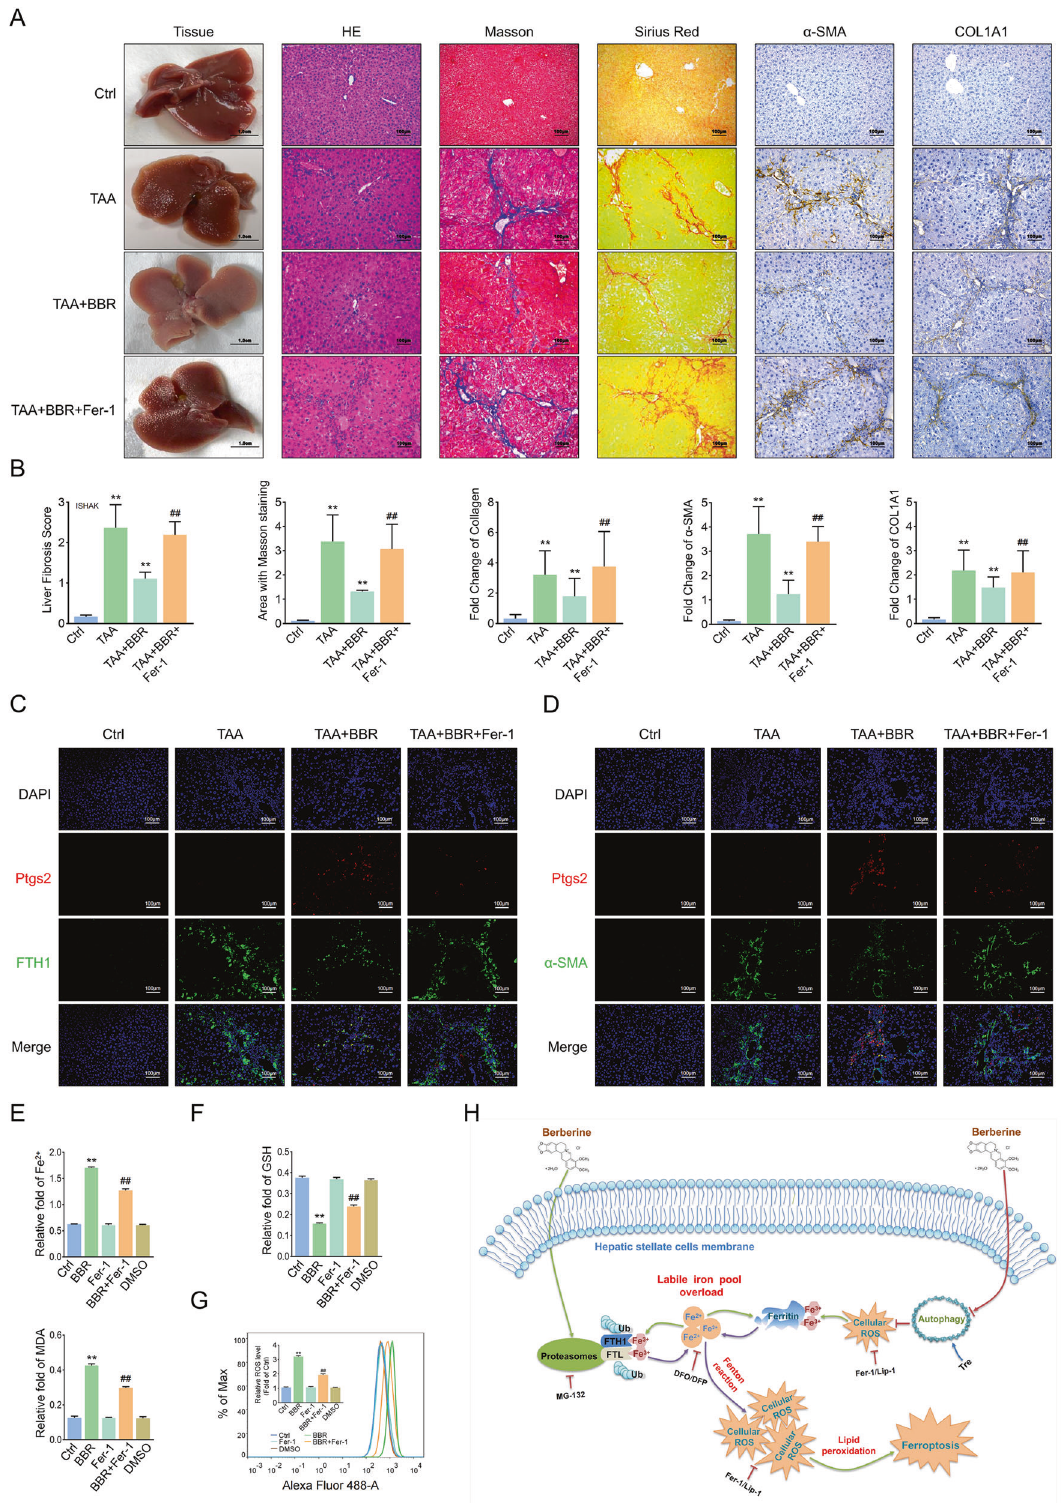
Fig. 8 Blockage of ferroptosis offsets the effect of BBR against liver fi brosis. Mice were divided into 4 groups: control group, TAA-treated group, TAA-treated group plus BBR (200 mg/kg/day) with or without Fer-1 (1 mg/kg/day). A , B General examination of liver tissues by H&E, Masson ’ s trichrome, and Sirius red staining were performed. Fibrotic biomarkers COL1A1 and α -SMA staining in liver sections (compared with the control group, ** P < 0.01; compared with the TAA plus BBR group, ## P < 0.01). C , D Mouse liver sections were costained with Ptgs2 and FTH1 or α -SMA. E – G HSC-LX2 was pretreated with Fer-1 (1 μ M) for 1 h; then the cells were treated with BBR (21 μ M) for 24 h, and ferroptotic events were investigated. H The underlying mechanism of BBR-induced HSC ferroptosis in liver fi brosis. The results are expressed as mean ± SD. Data are representative of three independent experiments; n = 3 – 6 in every group; Scales: 100 μ m. Representative photographs are shown. Compared with the control group, ** P < 0.01; compared with the BBR group, ## P < 0.01. Cell Death Discovery (2021)